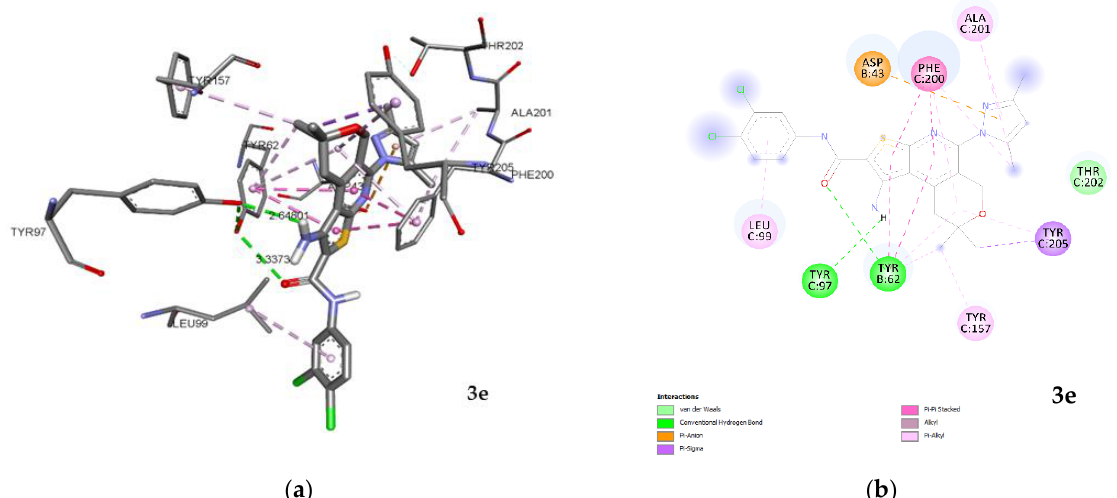
Figure 5. Visualization of the interaction of 3e with GABA A ; ( a ) spatial orientation and character of the interaction; ( b ) conformational map of complexation. Green lines are hydrogen bonds, orange — electrostatic and violet − hydrophobic interactions.